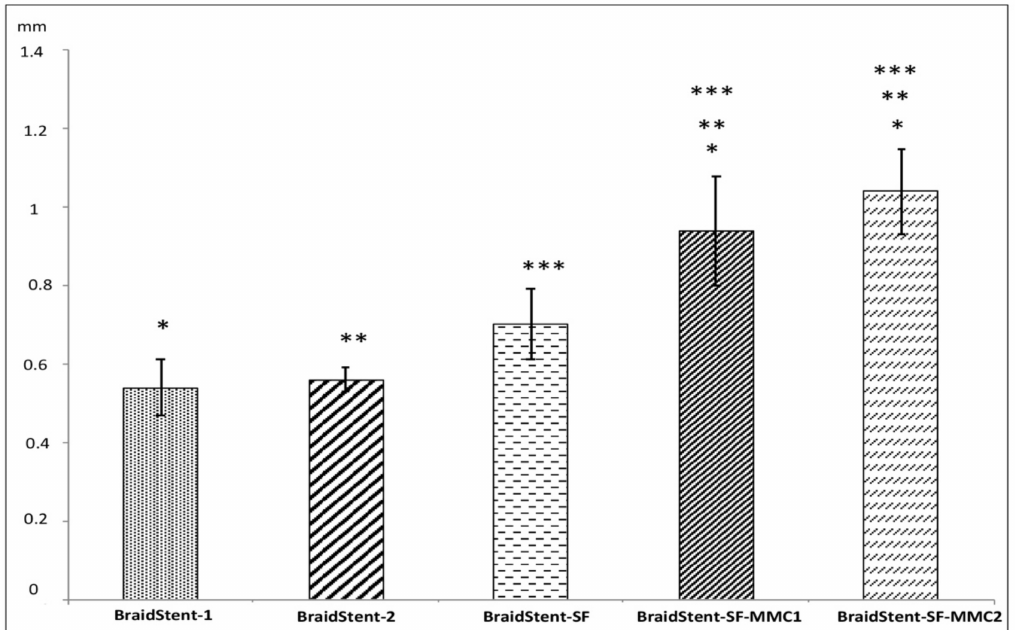
Figure 9. Stent thickness in the experimental groups at baseline (T0) (mm). Values indicate mean ± SD. Significance of the values between each tested group was determined by a one-way ANOVA and a post hoc Tukey test: (* p < 0.05) (BraidStent-1 versus the rest of experimental groups); (** p < 0.05) (BraidStent-2 versus the rest of experimental groups); (*** p < 0.05) (BraidStent-SF versus the rest of experimental groups). Table 1. Mitomycin C concentration release rate (mg/L). MMC release is assessed every 6 h in artificial urine in BraidStent-SF-MMC1 and BraidStent-SF-MMC2 stents, until it is not detected by HPLC-DAD. The variable mg/L MMC at 6 h follows a normal distribution but not at 12 h. A Student’s t -test for independent samples was performed in order to determine the differences at 6 h between groups. As for the study at 12 h, a Mann–Whitney test was performed. The trend in MMC concentration over the 6 and 12 h, between groups and within each group, was analyzed using